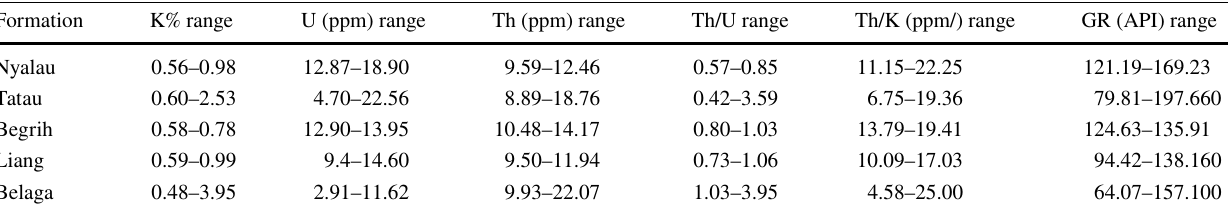
Table 1 Value of potassium, uranium and thorium concentration with Th/U ratio, Th/K ratio and the gamma ray in API obtained from the for- mations sample